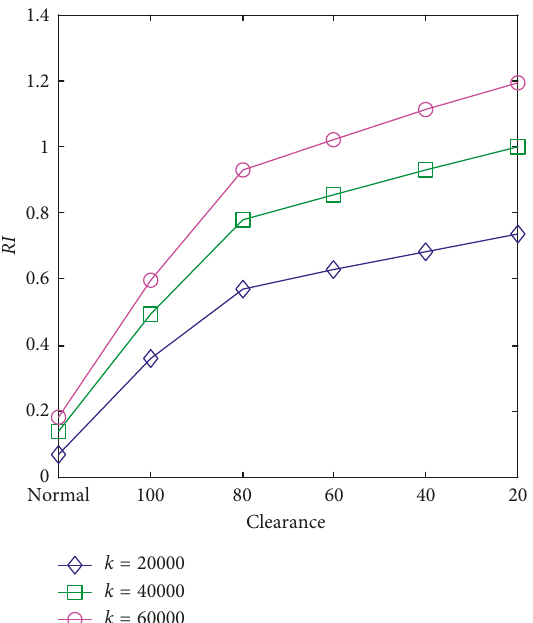
Figure 4: The trend of RI under different rub-impact clearances and rub-impact stiffnesses.